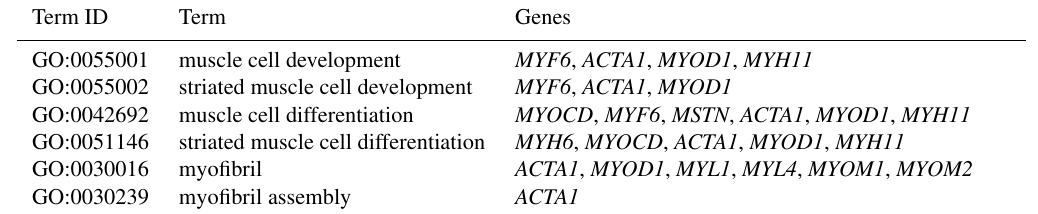
Table 3. Significantly enriched terms related to the processes of cellular